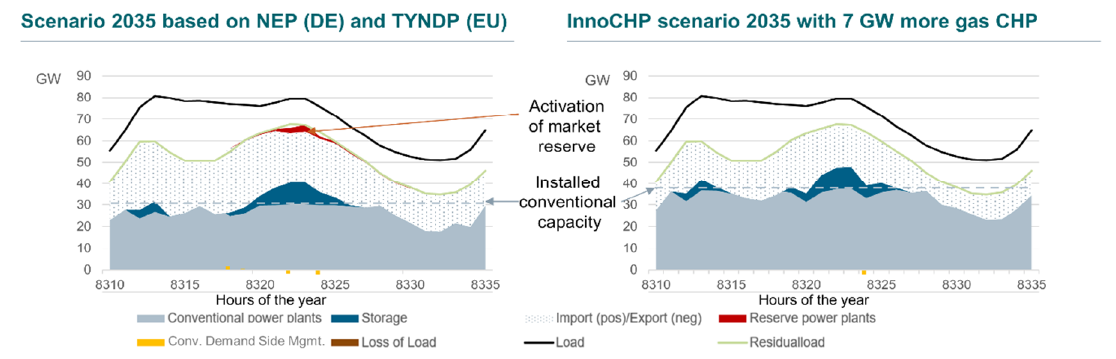
Figure 6. Comparison of hourly dispatch in base case ( left ) and InnoCHP scenario ( right ) for the year 2035. The red area shows the required amount of market reserve power plants. Residual load means electrical load minus non-dispatchable renewable generation.